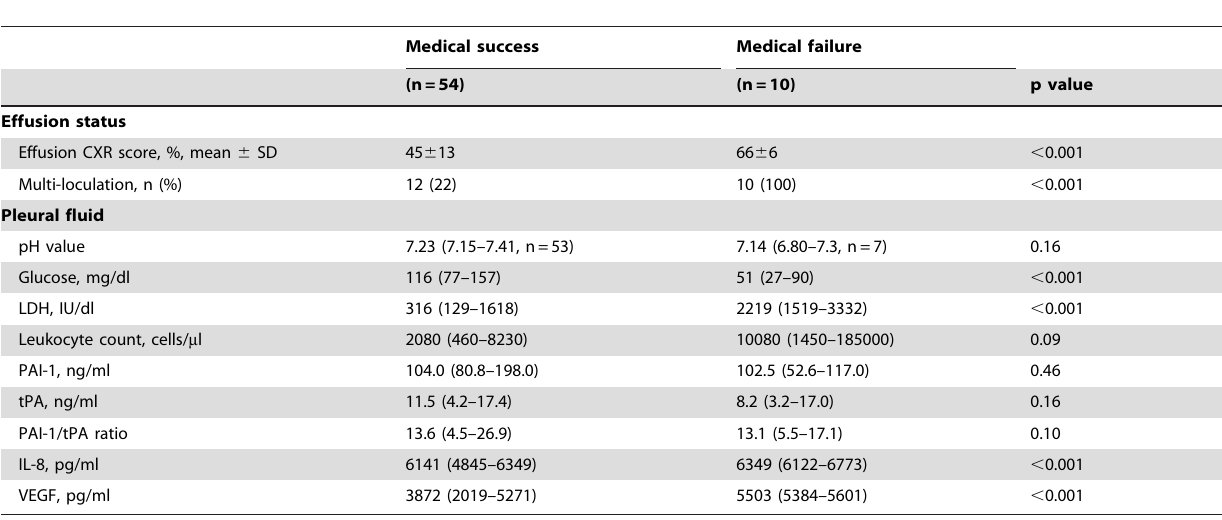
Table 5. Pleural Effusion Status and Variables between Medical Treatment Success and Medical Treatment Failure Patients.